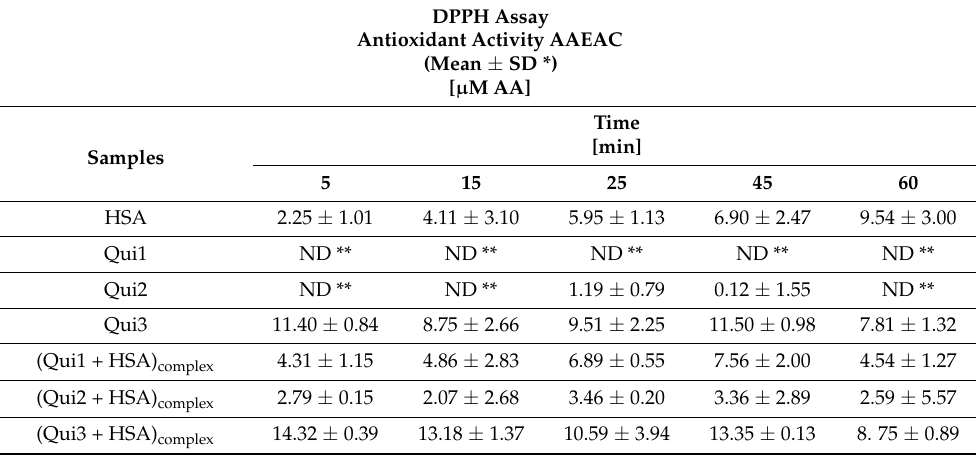
Table 6. The Total Antioxidant Capacity (AAEAC); ([Qui1] = [Qui2] = [Qui3] = 2 × 10 − 4